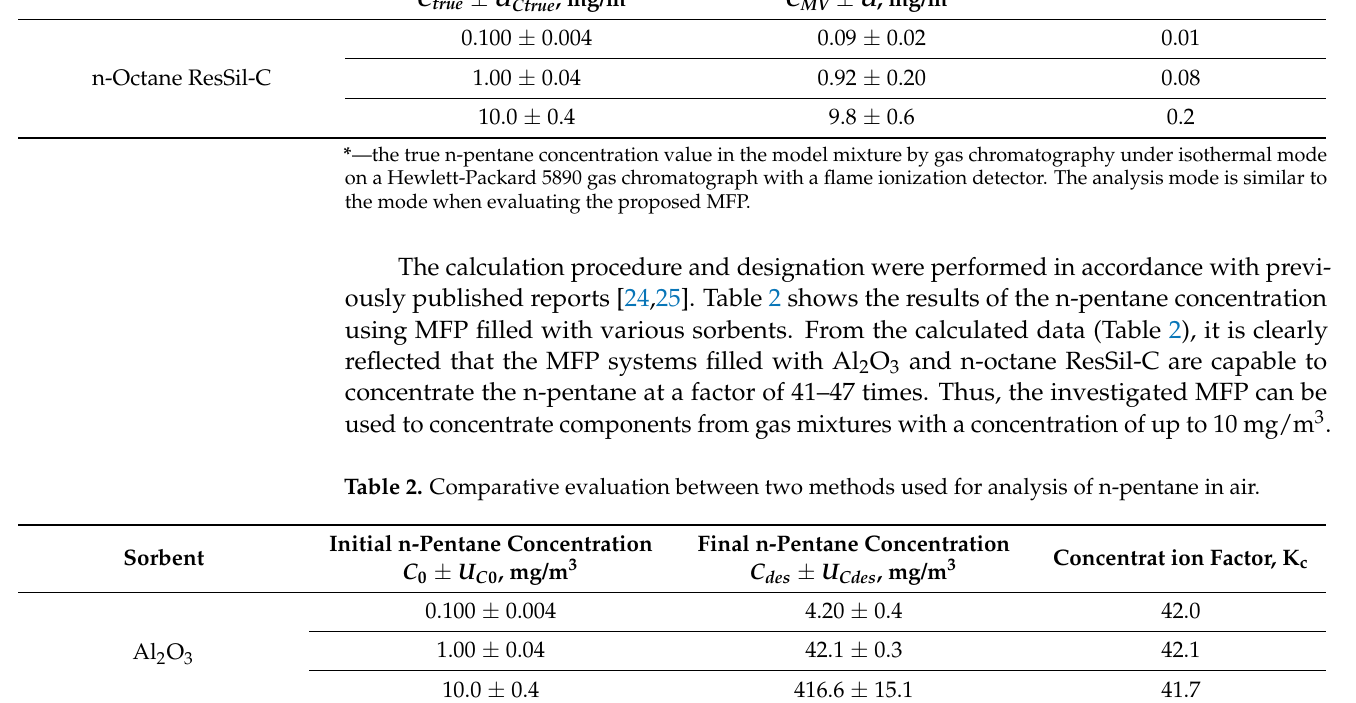
Table 1. Obtained results for n-pentane concentration by using as-developed MFP. Sorbent Used in Microfluidic Preconcentrator